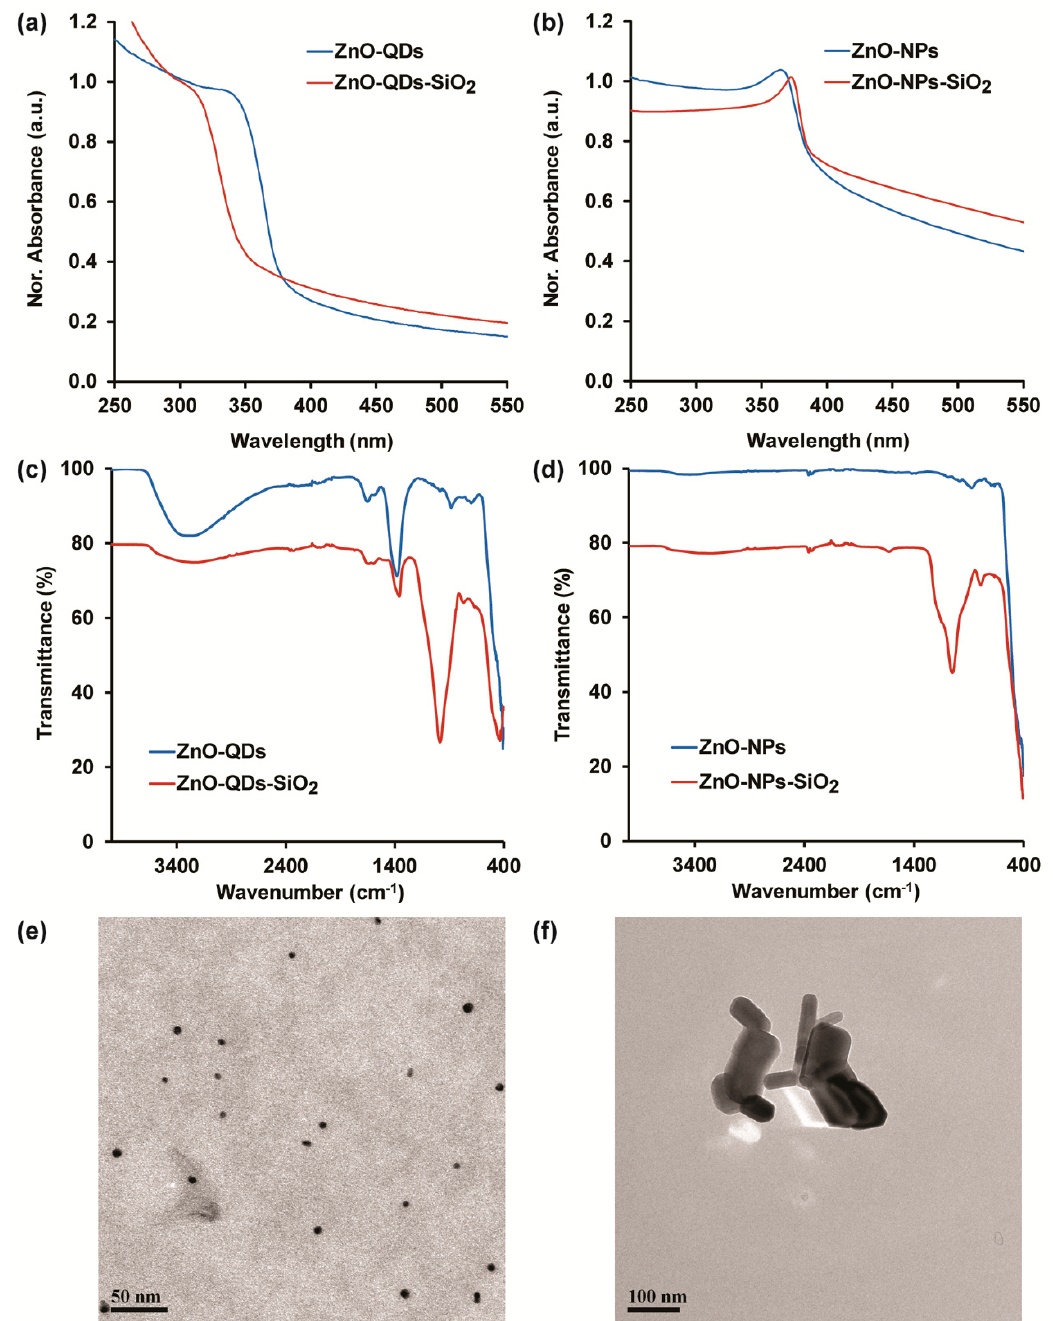
Figure 1. ZnO nanomaterial characterization before and after tetraethyl orthosilicate (TEOS) modification. UV-VIS spectra of ( a ) ZnO-QDs and ( b ) ZnO-NPs; attenuated total reflectance (ATR)- FTIR spectra surface characterization of ( c ) ZnO-QDs and ( d ) ZnO-NPs; Representative TEM images of ( e ) ZnO-QDs-SiO 2 and ( f ) ZnO-NPs-SiO 2